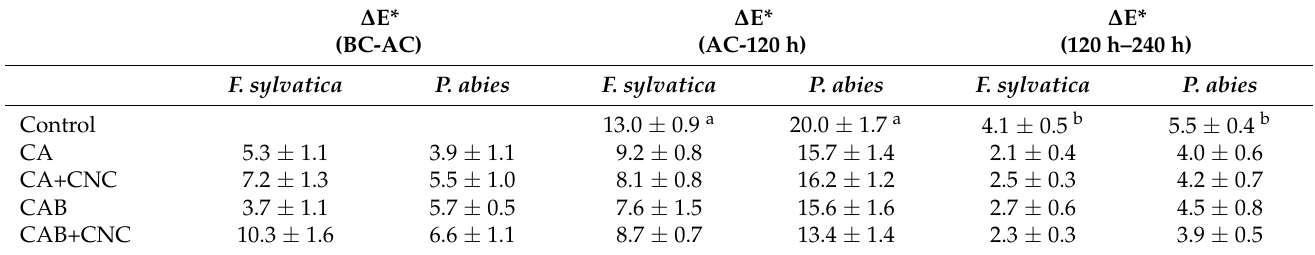
Table 4. Color difference results. BC: Before coating. AC: After coating. 120 h: After xenon exposure for 120 h. 240 h: After xenon exposure for 240 h. Control: uncoated wood, as control for artificial weathering